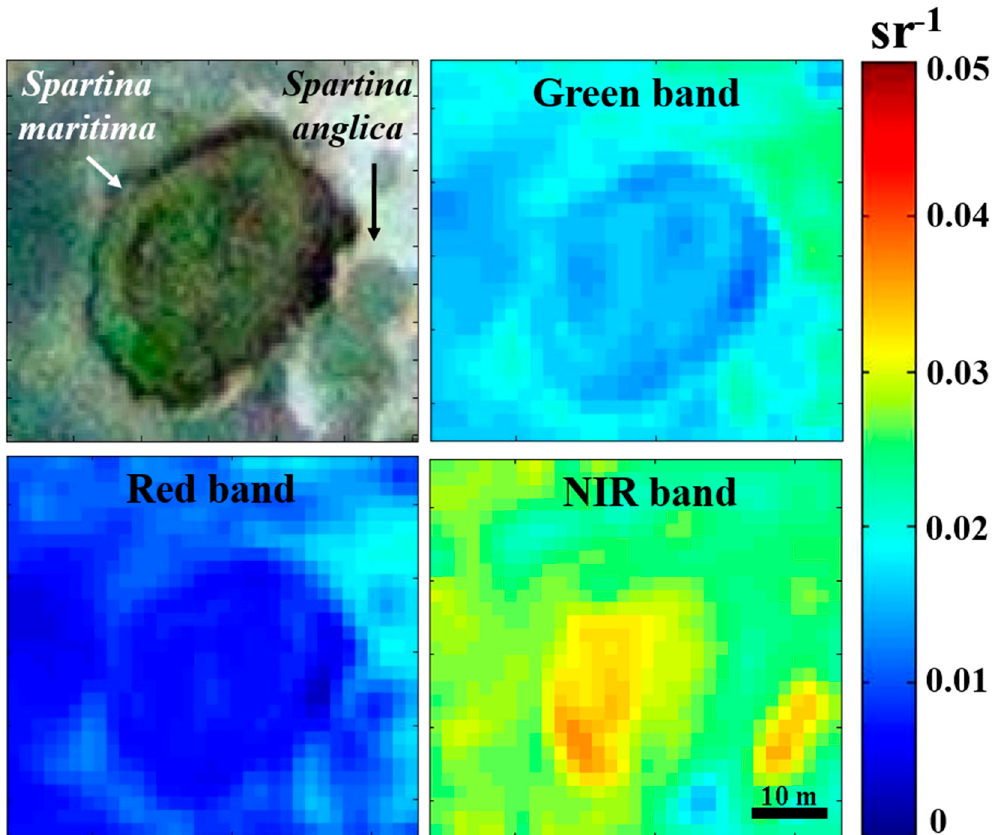
Figure 5. Remote sensing reflectance (sr − 1 ) values in the green (500–620 nm), red (590–710 nm) and NIR (740–940 nm) bands for the multi-spectral Pléiades images, acquired on 3 August 2016. The images zoom in on the well-identified Spartina anglica and maritima meadows (see red and blue boxes on the image of 2016, Figure 4).